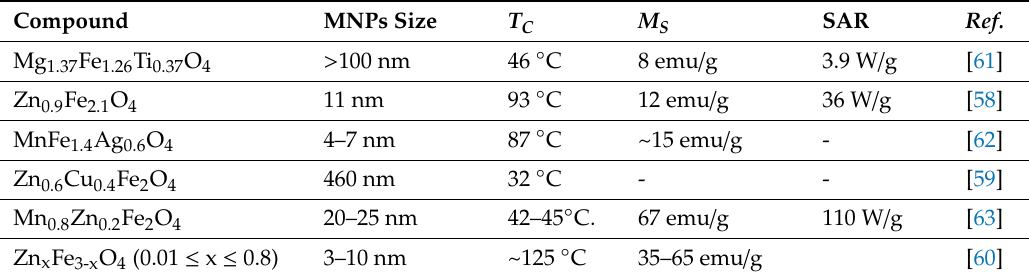
Table 1. T C , M S and SAR values of di ff erent mixed ferrite